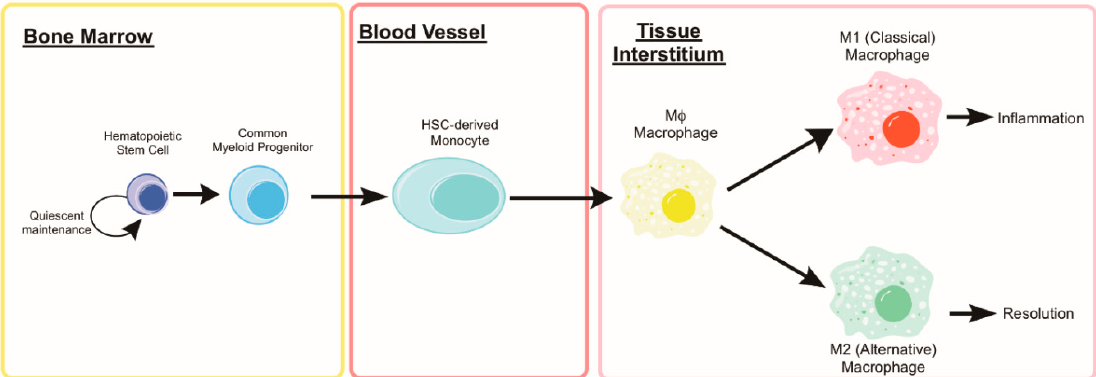
Figure 4. Development of Bone Marrow-derived Macrophages. Hematopoietic stem cells (HSCs) reside in their hypoxic niche within the bone marrow and maintain a quiescent state. When activated, the HSC can generate daughter cells of the common myeloid progenitor lineage and subsequently, into circulating monocytes. When stimulated by inflammatory cytokines (i.e., IL-6 or TNF, such as following muscle damage), monocytes undergo transcriptional changes that prevent apoptosis and enhance autophagy machinery during the differentiation into a macrophage. Mature macrophages (both classical and alterative) rely heavily on autophagy to aid in their function of clearing the damaged tissue and cellular debris that is the result of muscle injury.